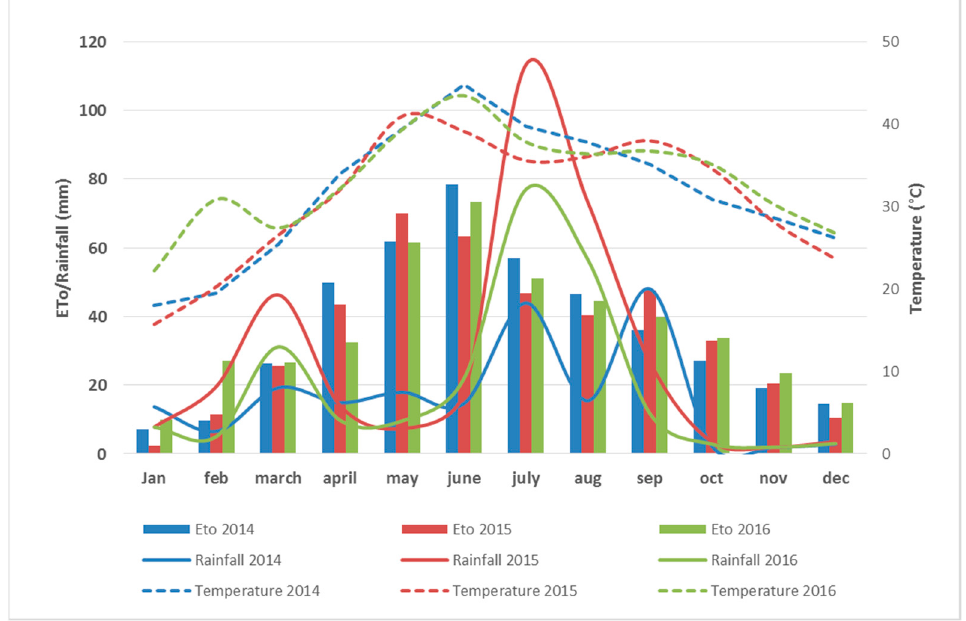
Figure 11. Distribution of reference evapotranspiration (ET0), temperature, and precipitation for 2014, 2015, and 2016.